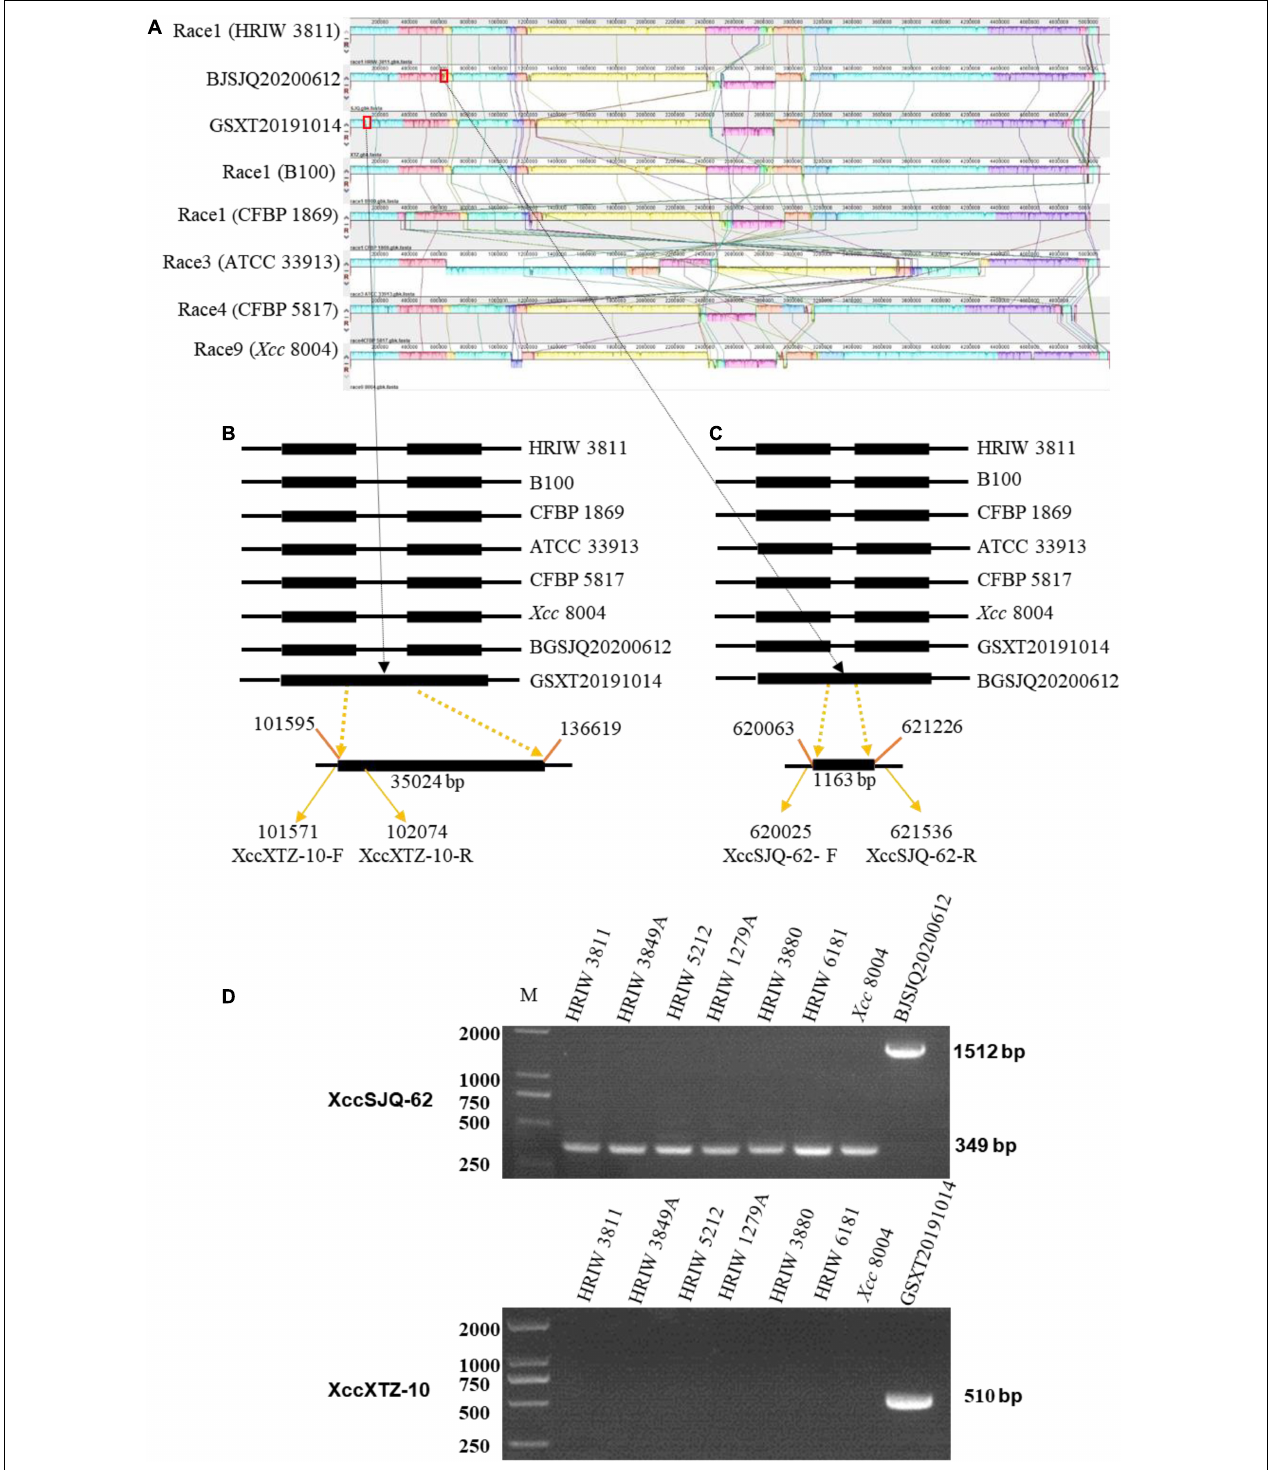
FIGURE 6 | Multiple alignments of the whole genome sequence of Xcc strains by Mauve (version 2.4.0) and the development of molecular markers. (A) Alignment of the whole sequence of eight Xcc strains (B100, HRIW 3811, CFBP 1869, ATCC 33913, CFBP 5817, and Xcc 8004). HRIW 3811 was used as the reference genome. Each genome is laid out horizontally with homologous segments outlined as colored rectangular solid boxes. The syntenic blocks are connected among the strains with lines. The rectangular boxes (red outline) indicate the positions of inserted sequence in the genome. (B) An insertion sequence of